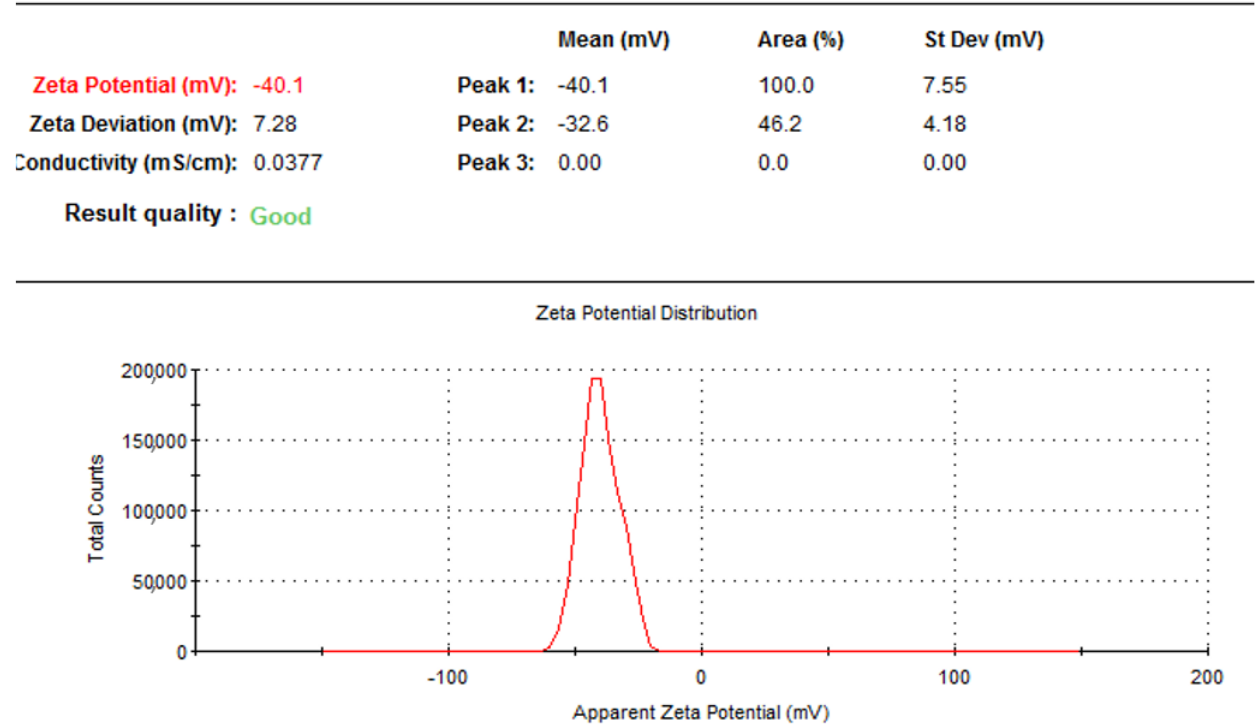
Figure 4. Zeta potential of optimized MoP formulation.